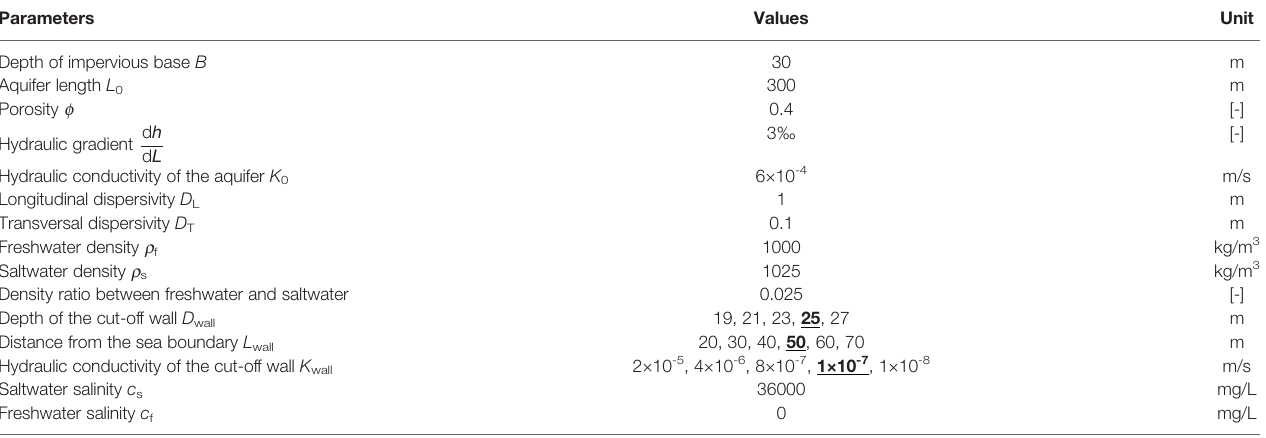
Boldfaced numbers with an underline stand for the values of D wall , L wall , and K wall used in the reference case.